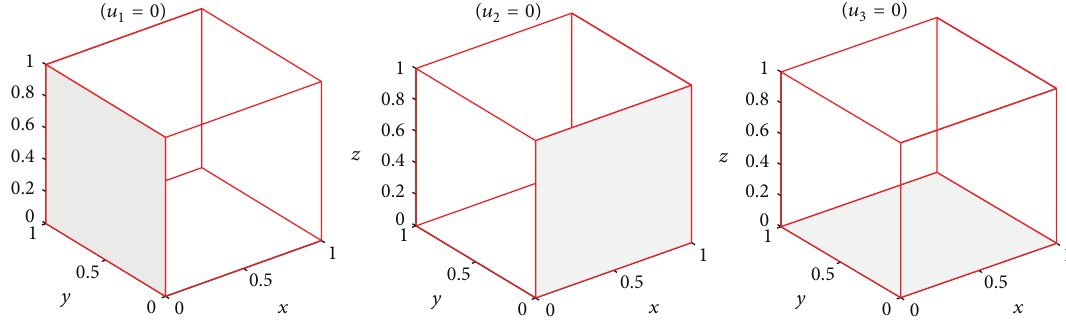
Figure 1: Slip boundary condition (divergence).